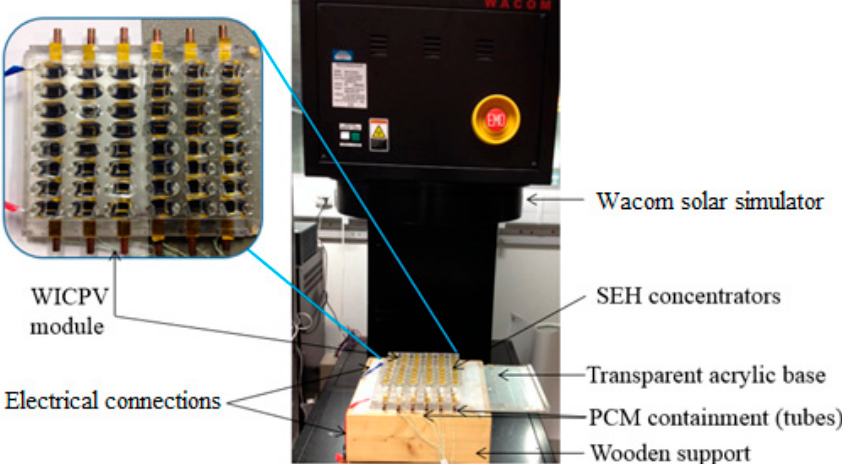
Figure 3. Experimental setup under the solar simulator and (in inset), the semitranspar- ency effect of the SEH system. the SEH